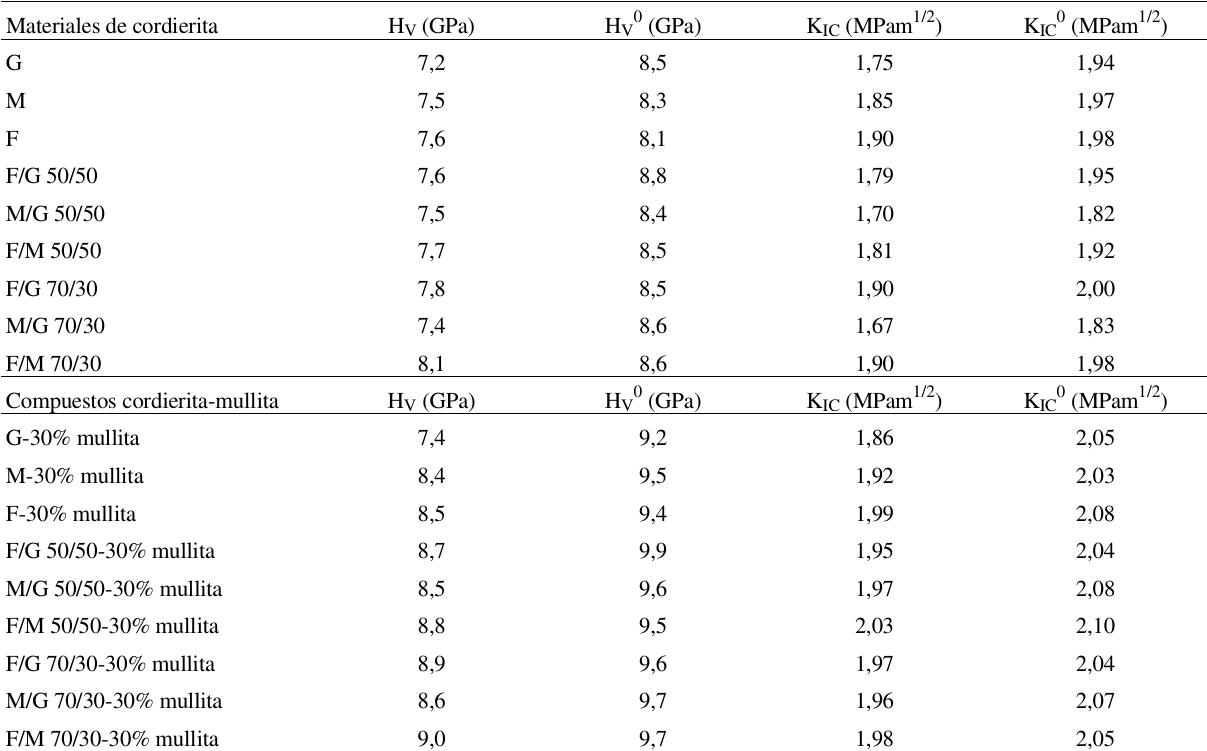
Tabla 1. Valores experimentales y corregidos a porosidad cero de dureza y factor crítico de intensidad de tensiones de los materiales de cordierita y cordierita-30%